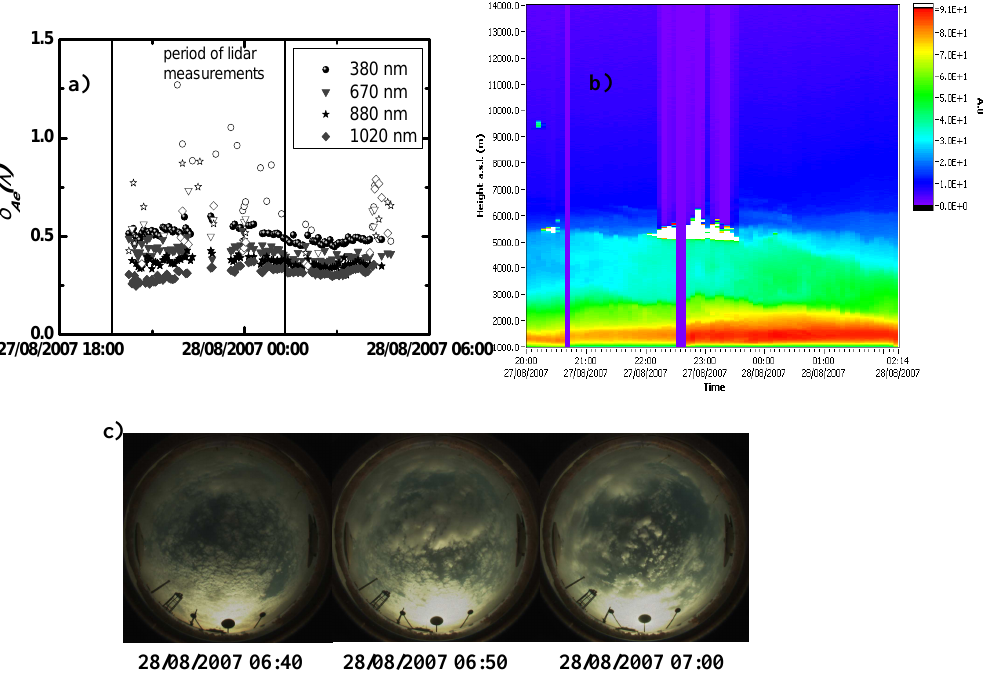
Fig. 5. (a) Temporal evolution of the aerosol optical depth at 380, 670, 880 and 1020nm during the night 27–28 August 2007. Empty symbols Figure 5: a) Temporal evolution of the aerosol optical depth at 380, 670, 880 and 1020 nm correspond to cloud-affected data and full symbols are cloud-free data. (b) Range corrected signal measured by lidar system at 532nm during the night 27-28 August 2007. Empty symbols correspond to cloud-affected data and between 27 August 2007 at 20:00UTC and 28 August 2007 at 02:15UTC. (c) All-sky images during the early morning of 28 August 2007 full symbols are cloud-free data. b) Range corrected signal measured by lidar system at 532 (times expressed in nm between 27 August 2007 at 20:00 UTC and 28 August 2007 at 02:15 UTC. c) All-sky images in the early morning of 28 August 2007.